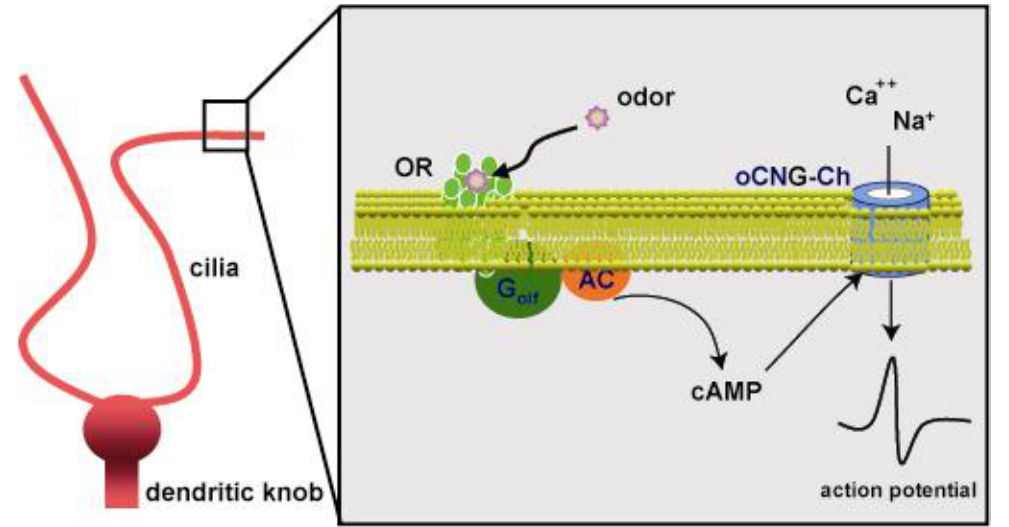
Figure 2. Olfactory signal